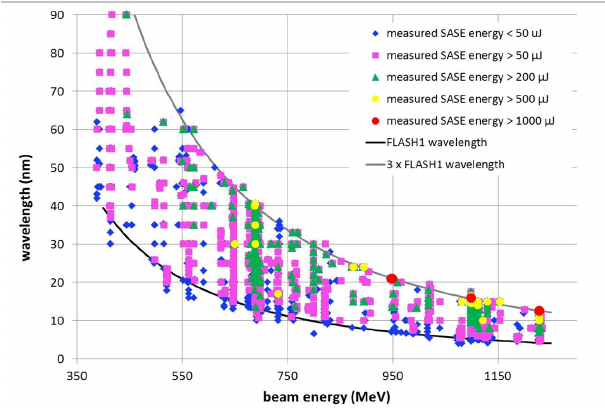
Figure 2. Wavelength tunability of FLASH2 for specific electron beam energies. The different symbols and colors refer to the achieved photon pulse energies. The upper and lower limits are given by three times the FLASH1 wavelength as a maximum (for a closed undulator gap) and the FLASH1 wavelength as a minimum.